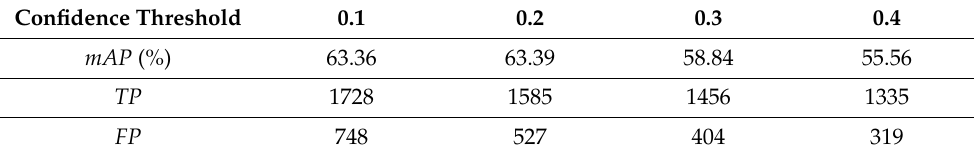
Table 2. Experiment according to variation in confidence threshold to determine the confidence score with the highest performance based on the GFEP + ACCP + MSD + FDSESI method.